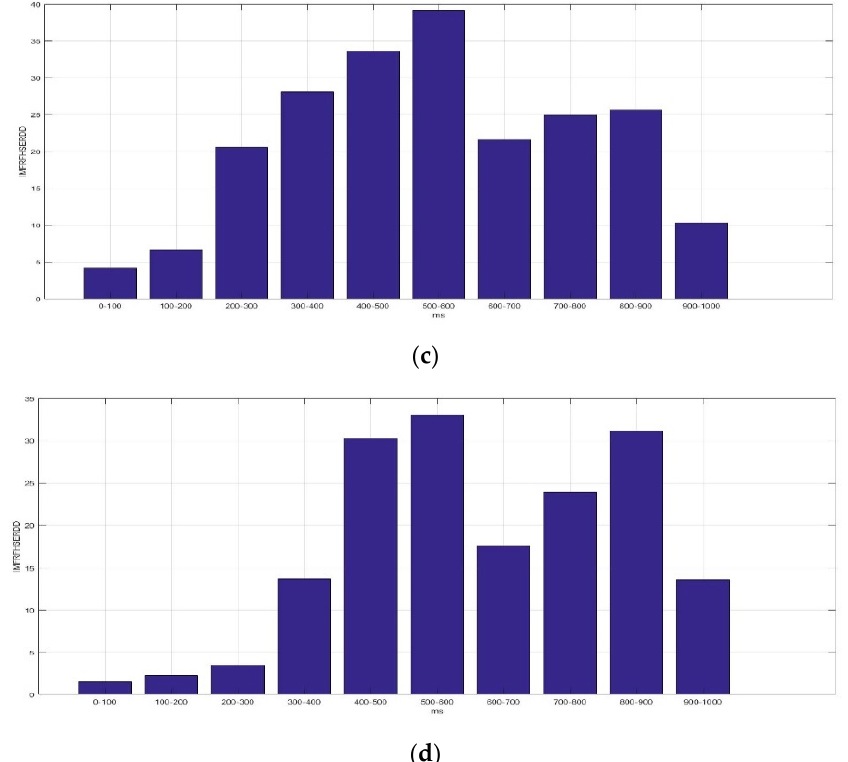
Figure 9. Average IMFRF HS energy refereed distribution density of IMF4 (HS4) for the delta rhythm during time interval of 0–1000 ms for F5AM, F5MI, F6AM, and F6MI, respectively. ( a ) Average IMFRFHSERDD values (F5AM HS4, 0.5–4 Hz), ( b ) average IMFRFHSERDD values (F5MI HS4, 0.5–4 Hz), ( c ) average IMFRFHSERDD values (F6AM HS4, 0.5–4 Hz), and ( d ) average IMFRFHSERDD values (F6MI, HS4 0.5–4 Hz).